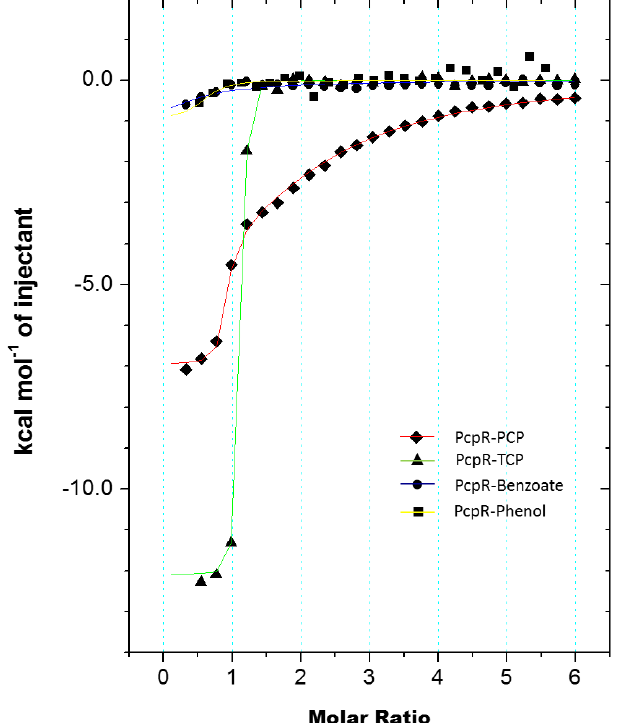
Figure 5. Measurement of PcpR inducer binding through isothermal titration calorimetry (ITC) experiments. The trend of heat released by serial injections of PCP, 2,4,6-TCP, sodium benzoate, and phenol. The data shows two sites-binding mode for PCP, one sites-binding mode for 2,4,6-TCP, and no significant association of either benzoate or